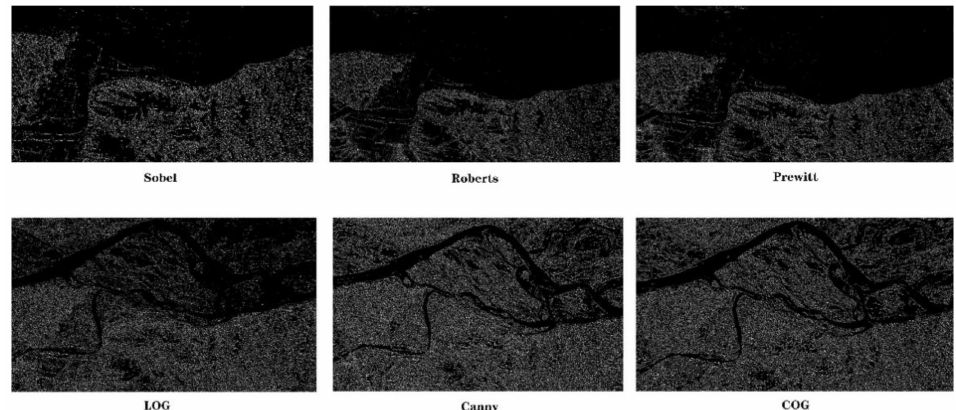
Figure 12. Edge extraction of the southern bank of the Yellow River from CORONA images.